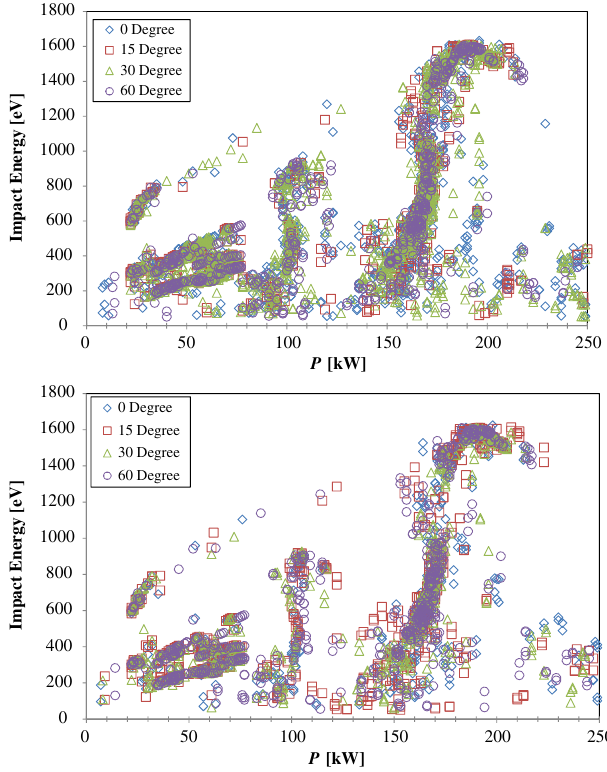
FIG. 12. Multipacting simulation at different frequencies: top plot—703.9 MHz; bottom plot—703.75 MHz.